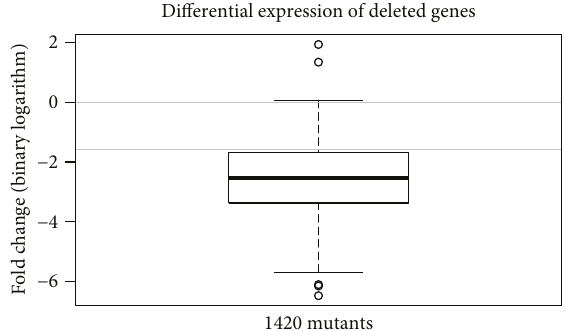
Figure 7: Empirical (gray bars) and estimated theoretical (red bullets) distributions with our fi nal data analytical Figure 6: Fold change distribution for deleted genes; horizontal gray lines at zero (no change) and − log 3 ≈ − 1 58 (optimal threshold). 2 Table 3: Results with P = 0 01 (zeros dropped).